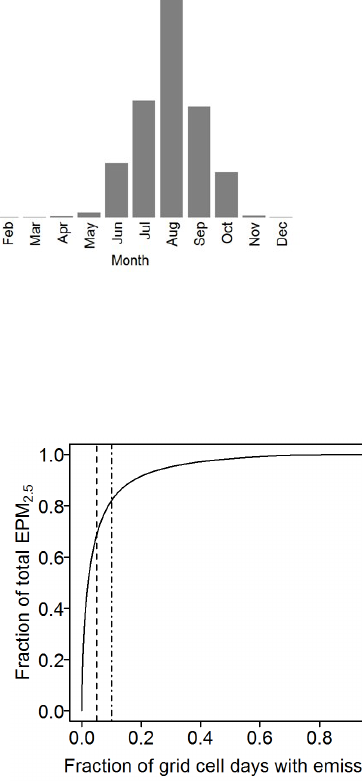
Figure 16. Fraction of regional 2003-2015 PM 2 . 5 emissions re- leased on peak days.